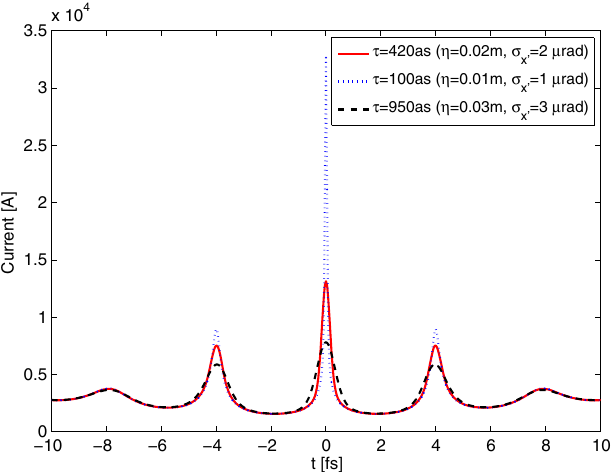
FIG. 5. Current distribution for different current width τ ¼ 420 as (red solid line), τ ¼ 100 as (blue dotted line), and τ ¼ 950 as (black dashed